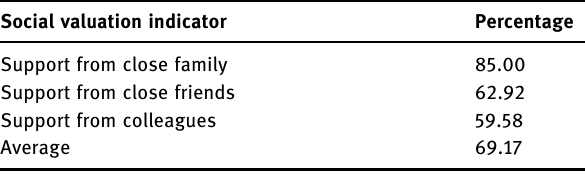
Table 7: Level of entrepreneurship competencies of poor farmers Entrepreneurship competence Entrepreneurship skills